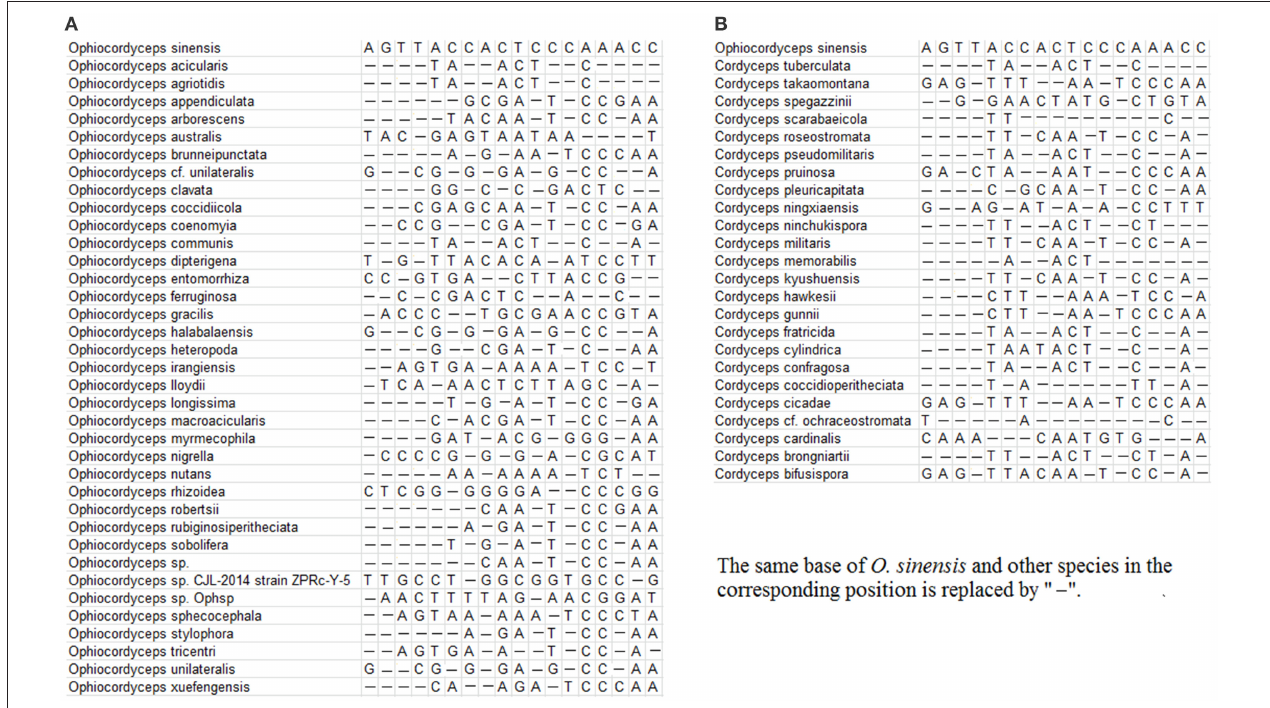
FIGURE 1 | Alignment of DCF4 primer binding regions from congeners and common adulterants. (A) DCF4 binding regions from O. sinensis and other Ophiocordyceps species. (B) DCF4 binding regions of O. sinensis and other Cordyceps species.